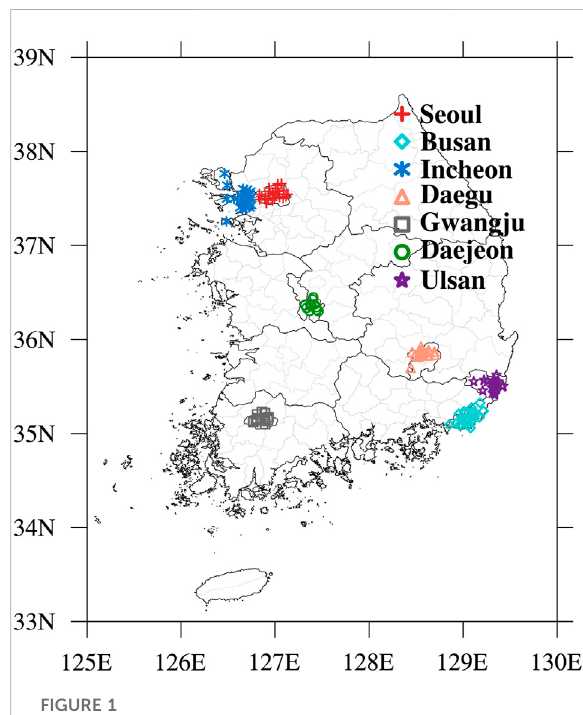
FIGURE 1 LocationofAIRKOREAurbanairqualitymonitoringstationsin seven megacities: Seoul, Busan, Incheon, Daegu, Gwangju, Daejeon, and